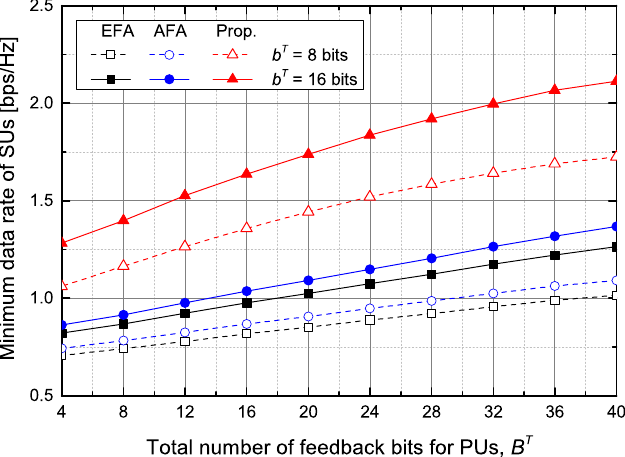
Figure 3. The minimum data rate of SUs versus the total number of feedback bits for